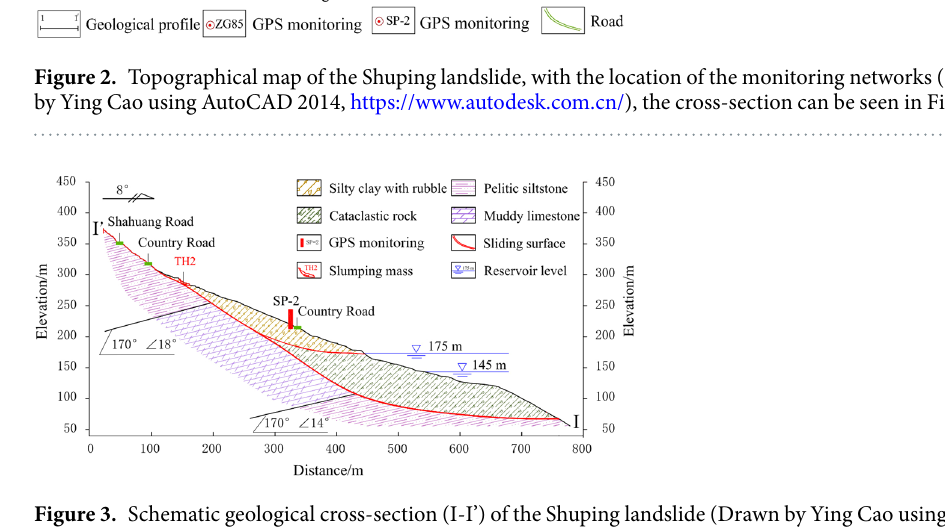
longitudinal dimension of 800 m and a width of 700 m (Fig. 2). The Shuping landslide is an ancient slumping deposit. It developed in the reverse syncline slope which is composed of mudstone and siltstone with muddy limestone of Triassic Badong Formation, with the dip direction of 120~173° and the dip angle of 9~38°. The mean depth of the sliding surface is about 50 m (Fig. 3). The Shuping landslide is a large colluvial mass movement with an estimated volume of 2750 × 10 4 m 3 . The eastern and middle part of the landslide is the main sliding mass with greater deformation. The area and volume of which are 35 × 10 4 m 2 and 1575 × 10 4 m 3 , respectively. Deformation characteristics. The Shuping landslide is an ancient landslide with complex geological con- ditions and a large volume. The deformation was significantly slow before the construction of the Three Gorges Dam (see boundary of landslide in Fig. 2). After the construction of the dam, the water level of Yangtze River raised from 75 m to 145 m a.s.l. Under the influence of such periodic reservoir fluctuations and heavy precipita- tion, the Shuping landslide revived. The landslide deformed partially which is shown as the main sliding mass in Fig. 2. The deformation monitoring of the sliding body is mainly based on the global positioning system (GPS) and macroscopic geological inspection. Eight effective GPS monitoring stations were installed surrounding the Shuping landslide (ZG85-ZG90, SP-2 and SP-6) (Fig. 2), with the layout of two vertical and three horizontal direc- tions to monitor the deformation of the whole landslide. Under the influence of periodic reservoir fluctuations and seasonal precipitations, the displacement speed of the Shuping landslide is found to be increasing between May and September in 2007 (Fig. 4). In this period, the landslide deformed 453.5 mm while the total deformation of 2007 was 593 mm. Several transverse arc-shaped